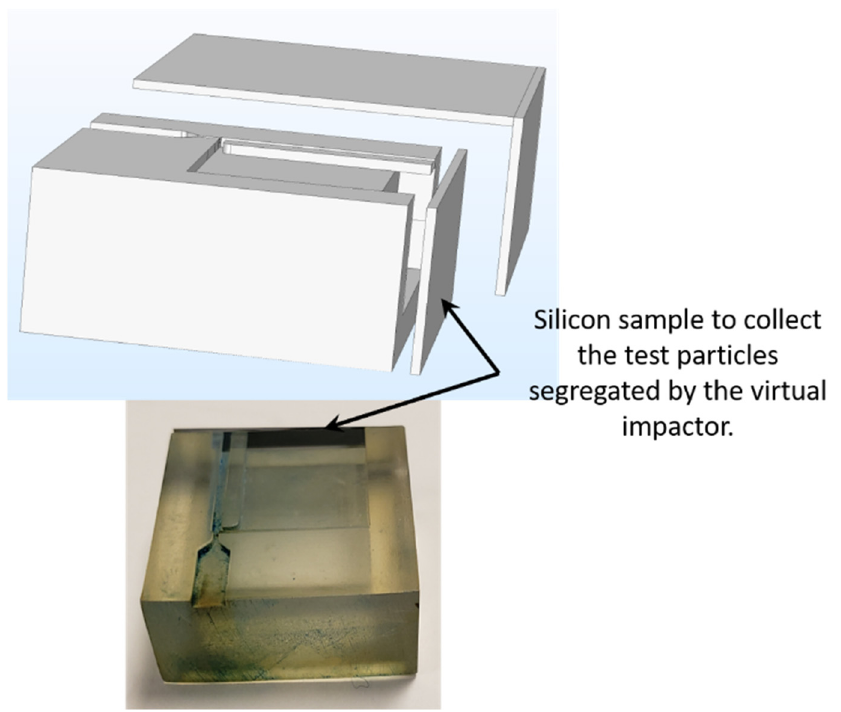
Figure 11. A silicon sample placed at the end of the major and minor flow channels collects the segregated particles. segregated